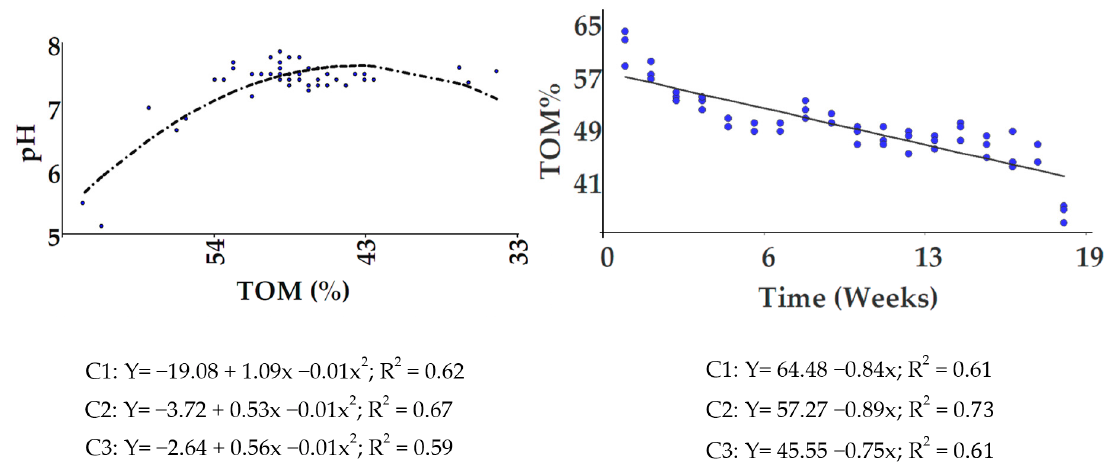
Figure 2. Predicted values for TOM% in C2 over 18 weeks showed a linear fit of TOM% = α × exp ( β × week), where: α = 57. 84 and β = − 0.02 ( p < 0.0001); AIC = 89.81.45; BIC = 92.49; σ = 2.83. Note: TOM = total organic matter.